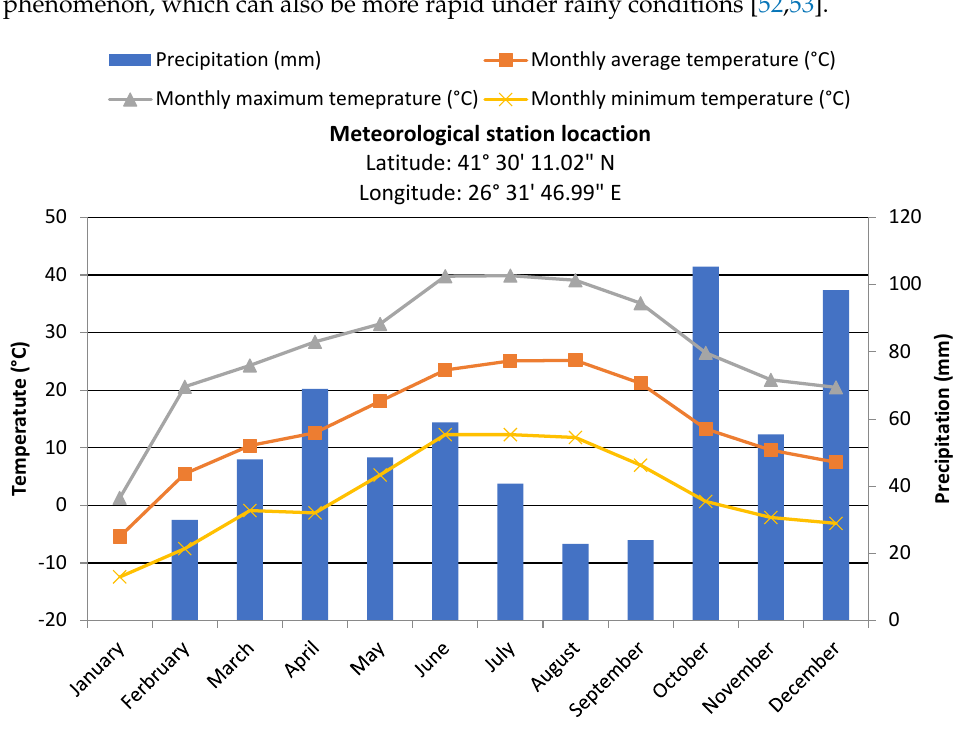
Figure 2. Meteorological data during the sampling period.